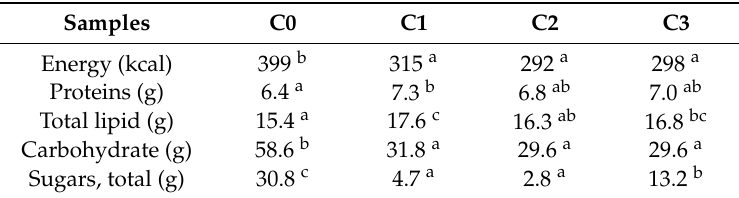
Table 3. Nutritional composition of cupcake samples per 100 g.